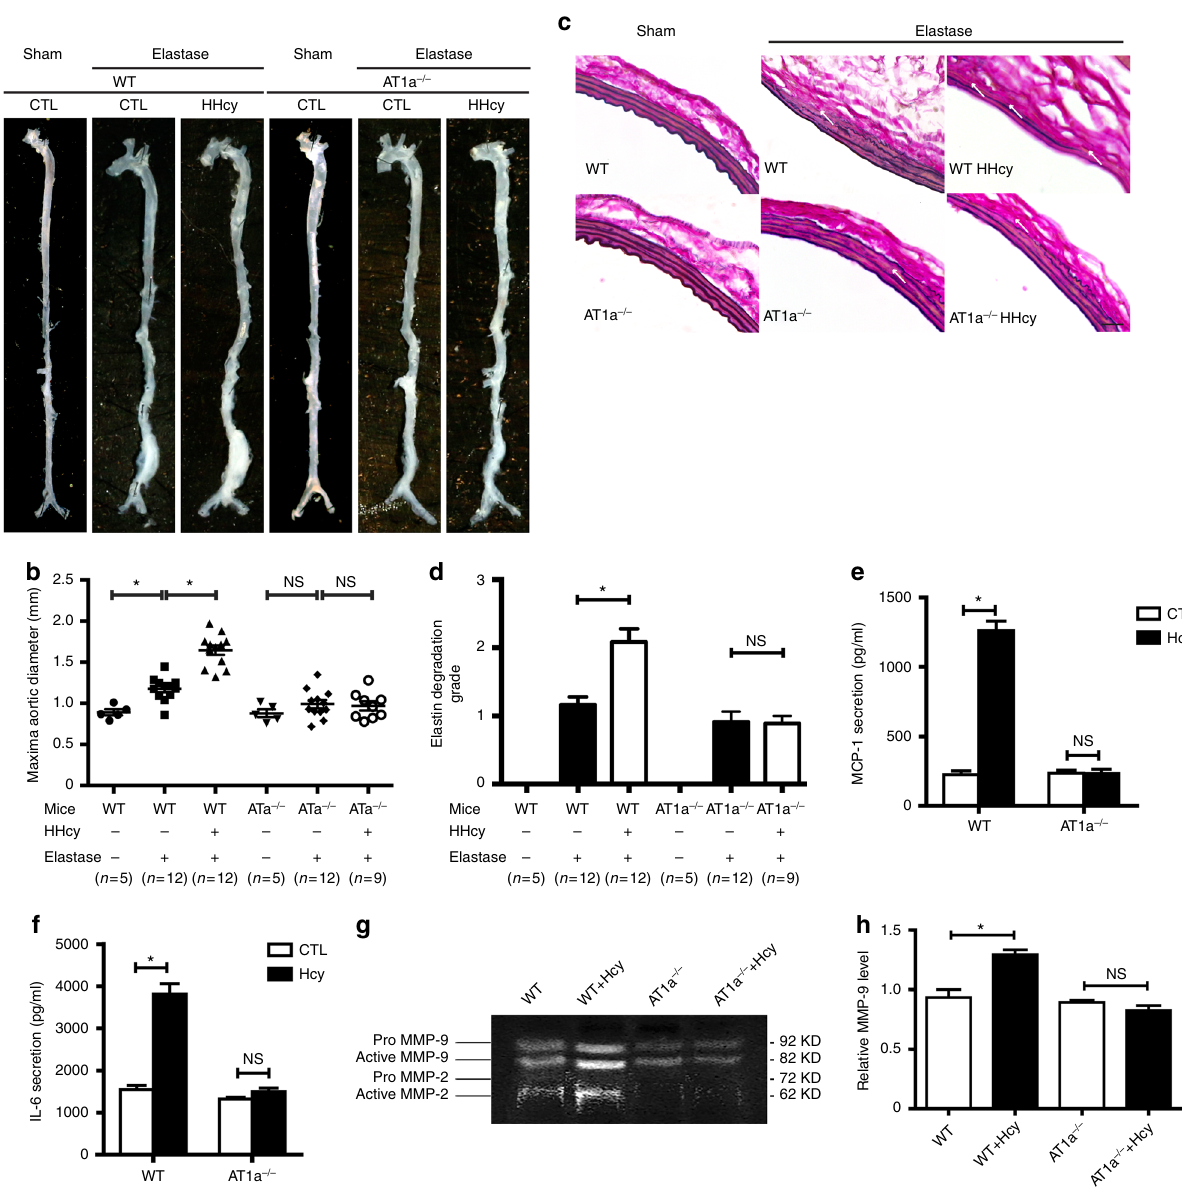
Fig. 1 HHcy aggravates AAA in mice and induces vascular injury through the AT1a receptor. a Representative photographs of elastase-induced AAA in WT mice and AT1a − / − mice with or without elastase treatment. HHcy, Hcy (1.8 g/L) in drinking water plus elastase treatment. N = 5 – 12. b The quanti fi cation of the infrarenal abdominal aortic diameters in mice with elastase-induced AAA. The data represent as mean ± SEM. N = 5 – 12, * P < 0.05, Kruskal – Wallis test followed by Dunn ’ s test. c Representative Verhoeff – Von Gieson staining of elastin degradation. Scale bar, 20 μ m. N = 5 – 12. d The quanti fi cation of elastin degradation. The data represent as mean ± SEM. N = 5 – 12, * P < 0.05, Kruskal – Wallis test followed by Dunn ’ s test. e , f Hcy (100 μ M)-induced WT and AT1a − / − mice abdominal aortic ring MCP-1 secretion and IL-6 secretion 60 min after stimulation. The data represent as mean ± SEM. N = 9 – 12. * P < 0.05, two-way ANOVA followed by the Bonferroni post hoc test. g , h Representative gelatin zymography and quanti fi cation (active MMP-9) of conditioned medium of abdominal aortic rings from WT and AT1a − / − mice after Hcy (100 μ M) ex vivo stimulation for 20 h. The data represent as mean ± SEM. N = 6. * P < 0.05, two-way ANOVA followed by the Bonferroni post hoc activated intracellular Ca 2+ signaling, which was blocked by tel- the AT1 receptor, we assessed G-protein-dependent signaling, including PKC and ERK1/2 phosphorylation, intracellular Ca 2+ misartan pretreatment (Fig. 2f, Supplementary Fig. 7a, Supple- levels and NFAT signaling, as well as arrestin-mediated activa- mentary Table 4). Dual-luciferase reporter assays of NFAT were tion, including β -arrestin 2 translocation and receptor inter- then conducted to demonstrate that Hcy dose-dependently acti- nalization, in HEK293A cells transfected with the human AT1 vated intracellular NFAT signaling (Fig. 2g, Supplementary receptor. Compared to Ang II (Supplementary Fig. 6a – c), Hcy at Table 5), although to a lesser extent than Ang II (Supplementary 100 μ M resulted in delayed but sustained PKC and ERK1/2- Fig. 7b). Telmisartan pretreatment reversed Hcy-induced NFAT MAPK phosphorylation, which was abolished by pretreatment activation (Fig. 2g, Supplementary Table 5). In parallel, similar to with the AT1 receptor blocker telmisartan (1 μ M) (Fig. 2a – e). Ang II (Supplementary Fig. 8a, b), Hcy stimulation for 15 min Similar to Ang II (Supplementary Fig. 6d), Hcy dose-dependently caused β -arrestin 2 translocation, co-localization with the AT1